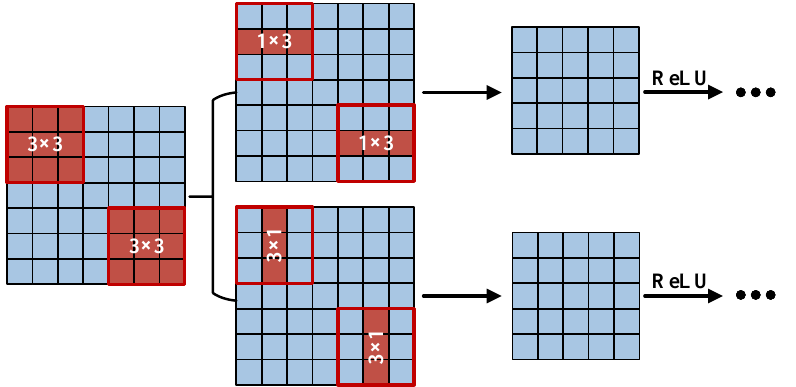
Figure 4. The details of asymmetric structural convolution